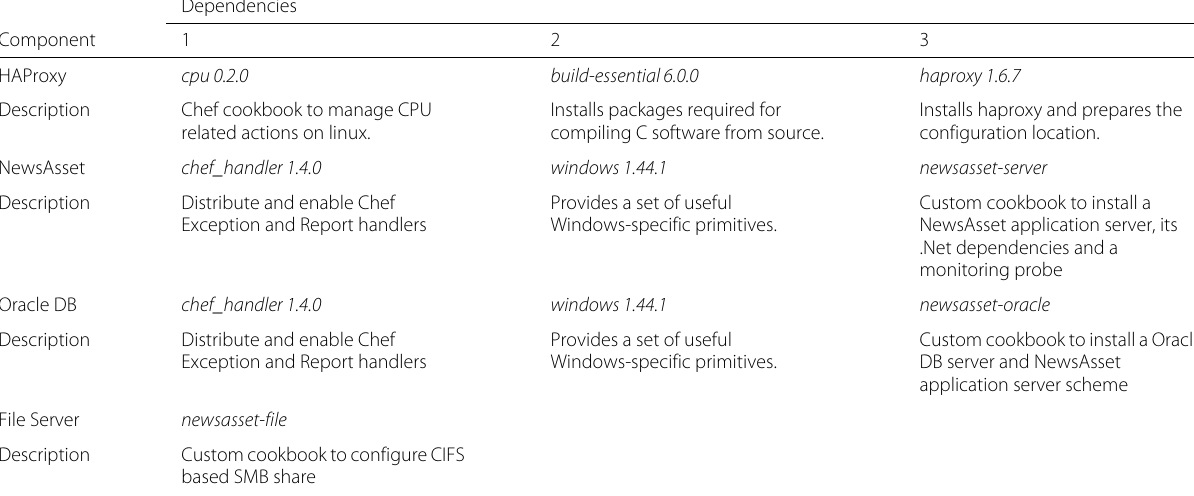
Table 1 NewsAsset application software